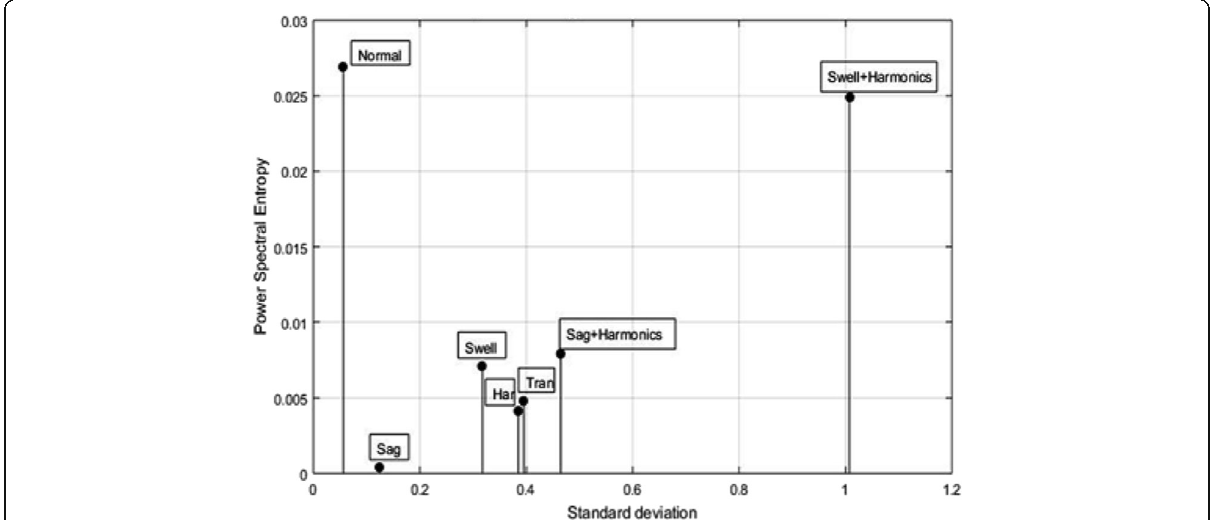
Fig. 6 Power spectral entropy Vs Standard deviation of PQ